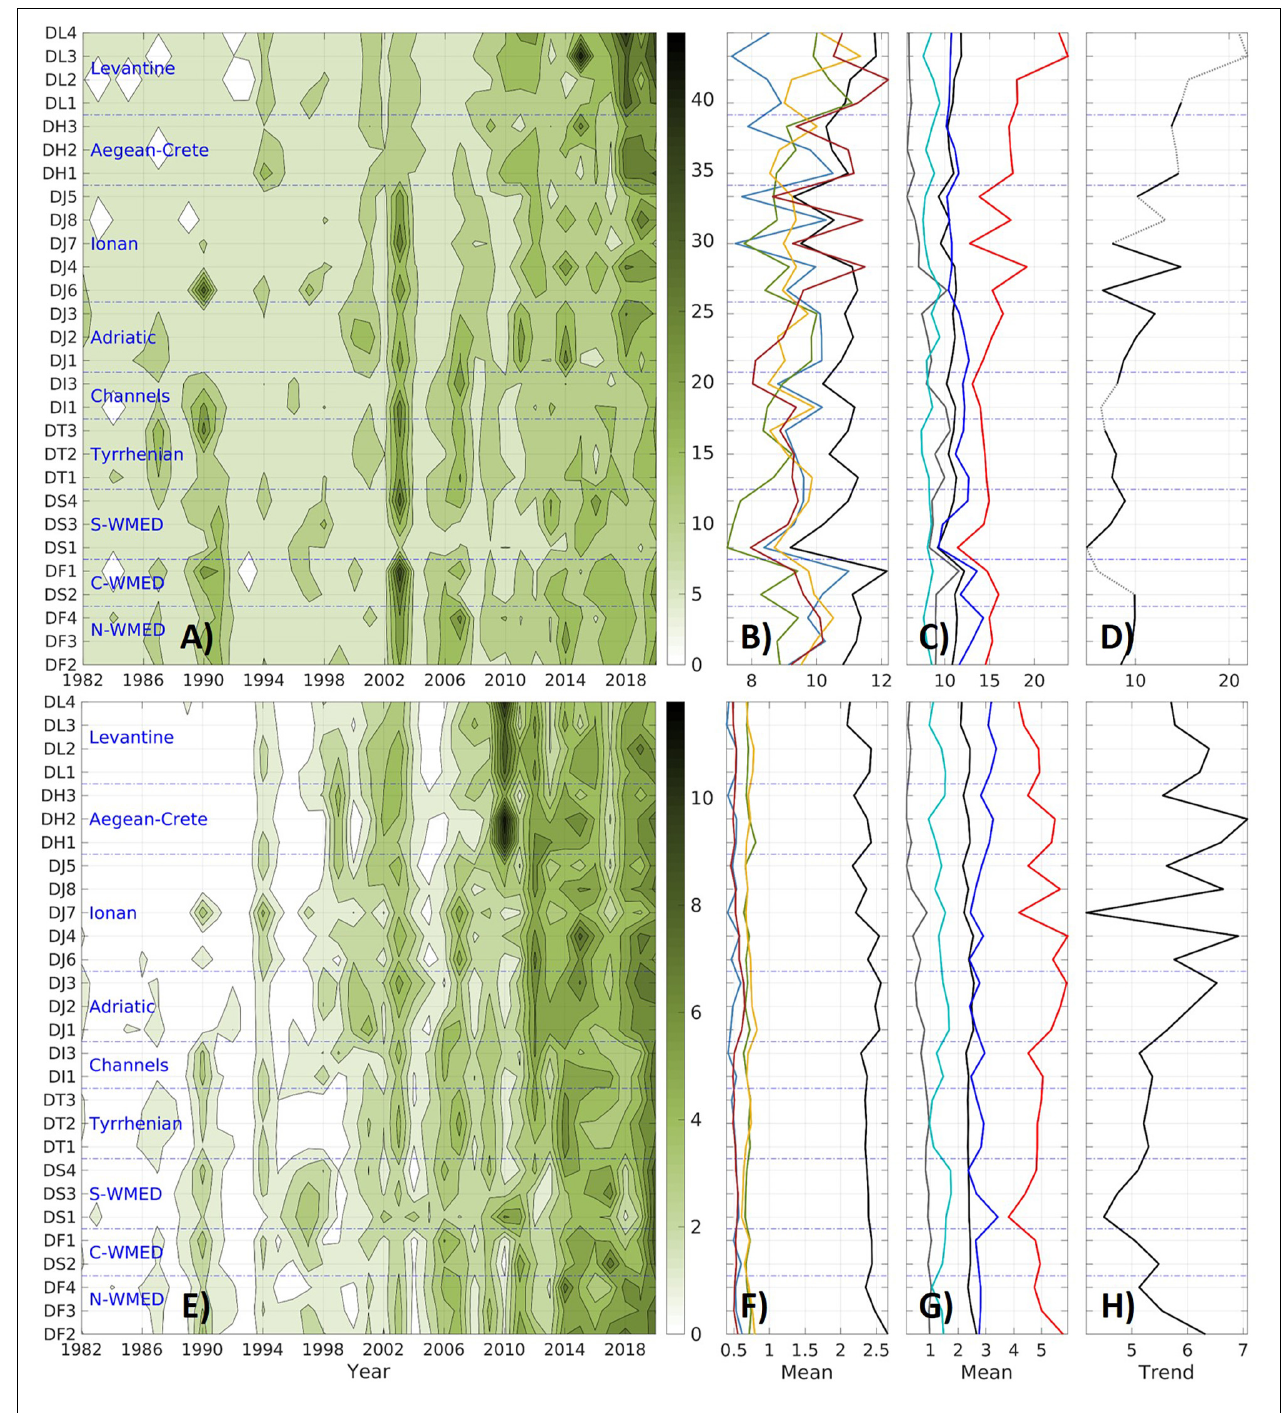
FIGURE 8 | Same as Figure 7 for mean duration (A–D) (in days) and number of events (E–H) .